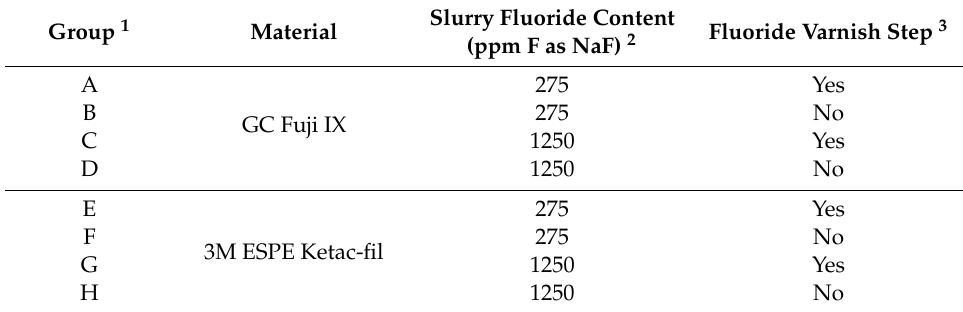
Table 1. Summary of the experimental groups used in the study with their respective treatments. Slurry Fluoride Content Group 1 Material (ppm F as NaF)